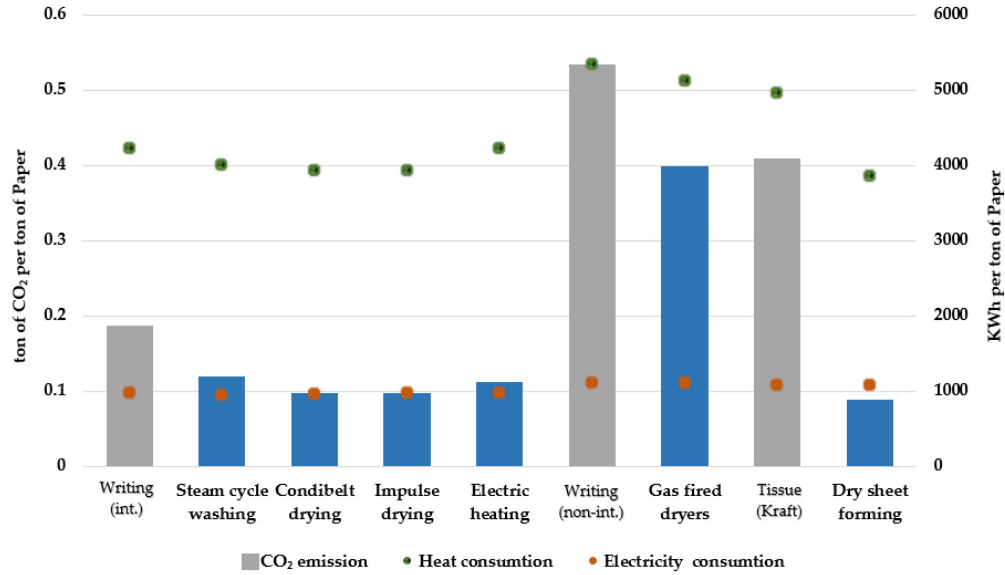
Figure 7. The effect of technology application on the CO 2 emission, heat, and electricity consumption compared to the current status of paper grade production.